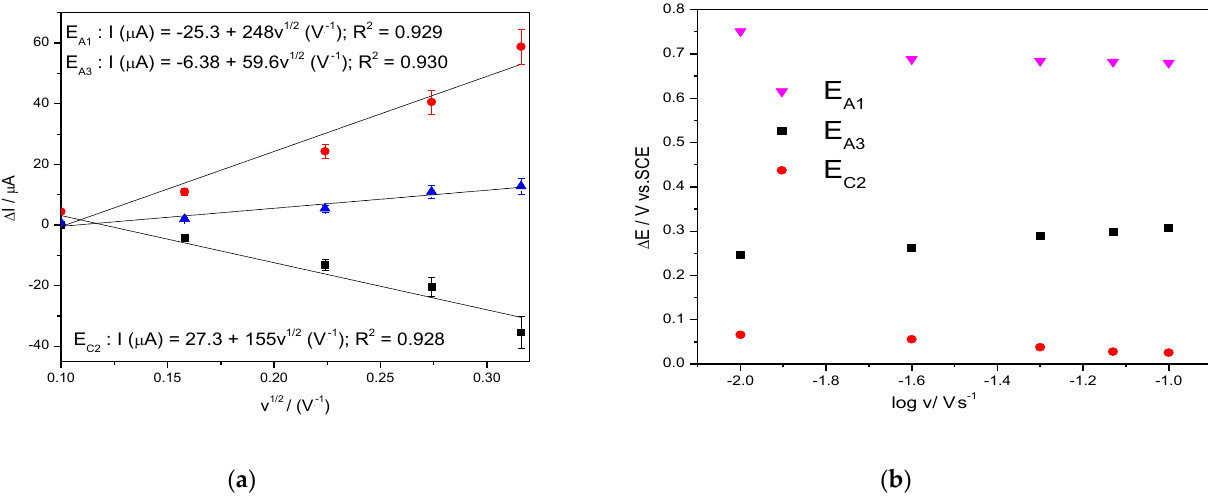
Figure 4. Dependence of the anodic peak currents vs. square root of the scan rate ( a ); evolution of the detection potential values vs. the logarithm of the scan rate ( b